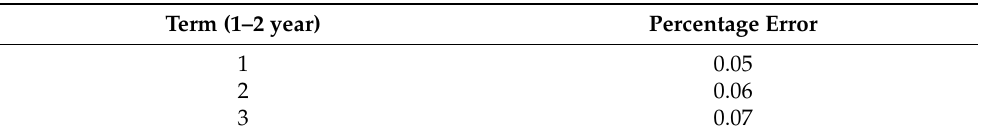
Table 7. Numerical integration errors associated with a selection of results in the post-catXL AAL decompositions provided in Figure 8. Column 1 provides the occurrence loss order (for the 1–2 return period layer) and Column 2 the percentage